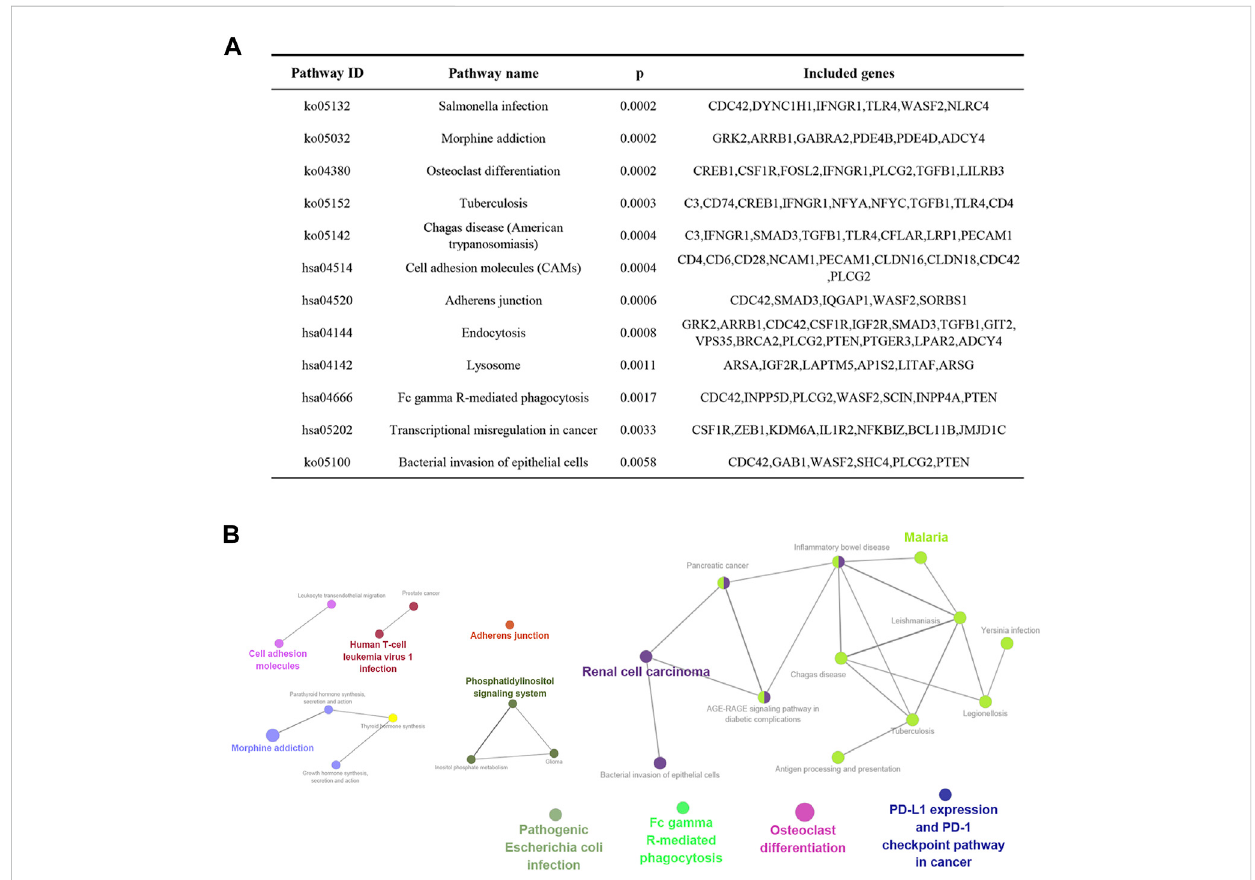
FIGURE 3 KEGG enrichment analysis of overlapping genes obtained from the intersection between DEGs and miRNA target genes. (A) Genes involved in enriched signaling pathways. (B) Network of the most highly enriched signaling